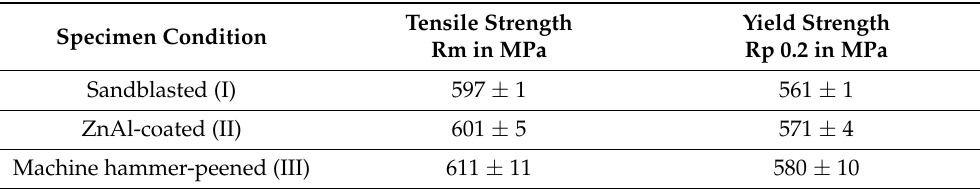
Table 4. Average tensile properties for two specimens each: Sandblasted (I), ZnAl-coated (II) and machine hammer-peened (III) specimens.